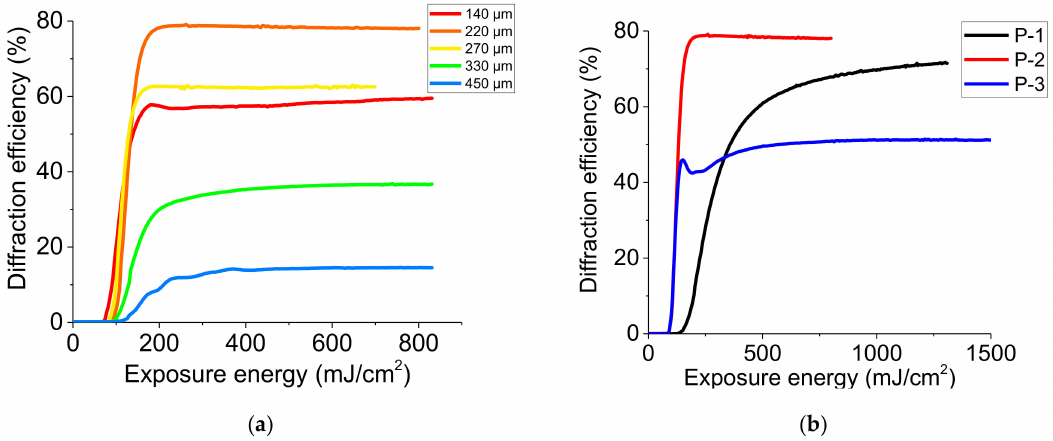
Figure 3. ( a ) Variation in the di ff raction e ffi ciency with exposure energy for the P-2 series with various sample thicknesses; ( b ) representative di ff raction e ffi ciency vs. exposure energy at three initiator concentrations. Sample thicknesses for P-1 to P-3 is 230, 220, and 230 µ m,